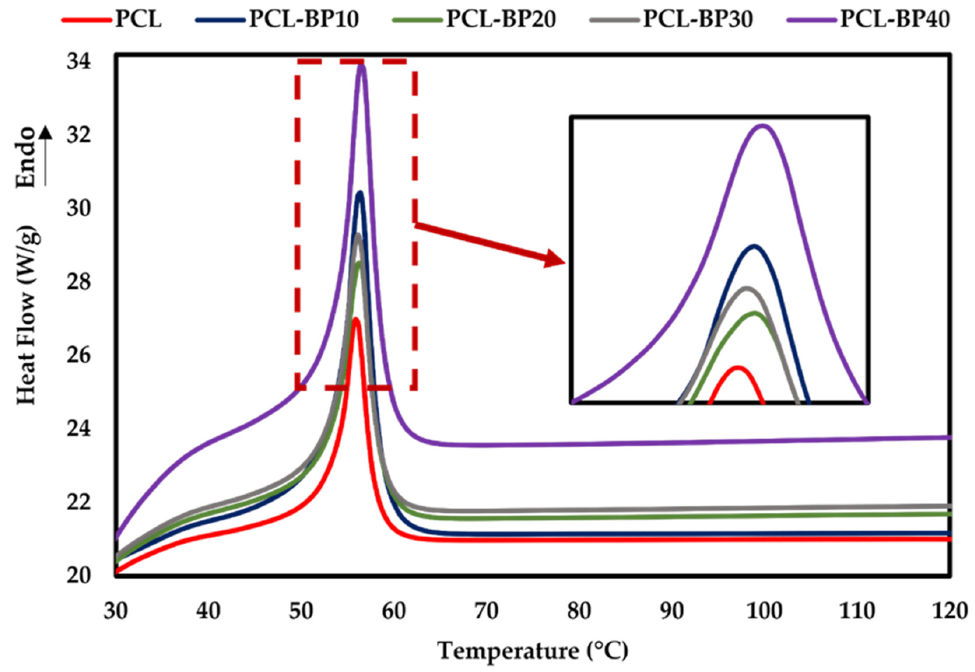
Figure 12. DSC curves of PCL and PCL-BP